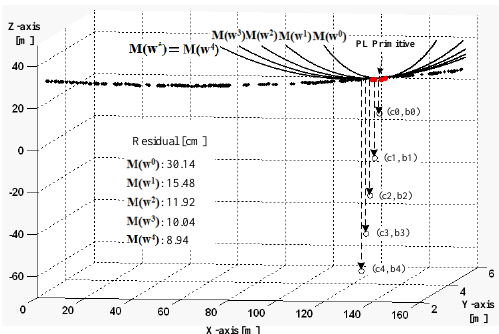
Figure 5. Possible alternative hypotheses from M(w 0 ) to M(w 4 ) determined by moving the sag position from b 0 to b 4 at the current PL primitive (red color) and the selection of the optimal power line model (M(w 4 ) = M(w * )) with the minimum residual.